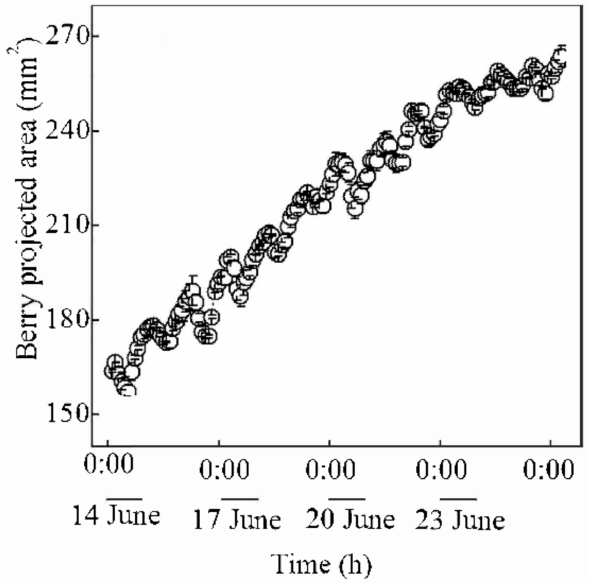
Figure 15. Theoretical curve of the change of the projection area of the berries of Sunshine Muscat grapes